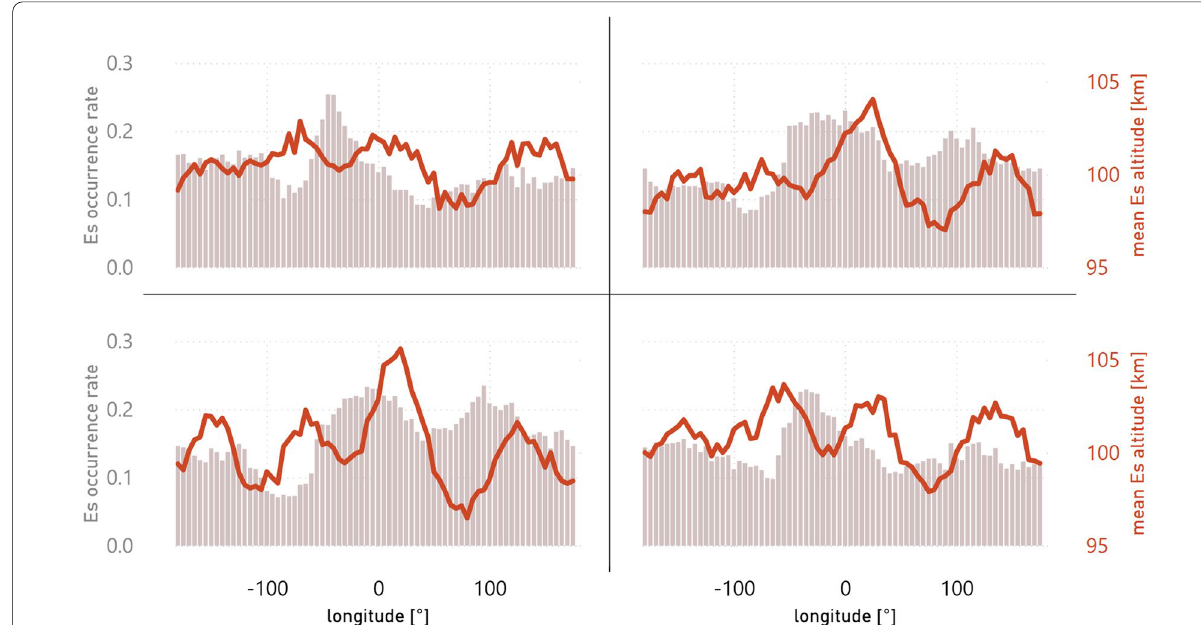
Fig. 7 Seasonal sporadic E occurrence rates (gray bars) and mean altitudes (orange line) along a narrow belt ( equator. The upper row displays winter (left) and spring (right) conditions. Summer (left) and autumn (right) conditions are found in the bottom